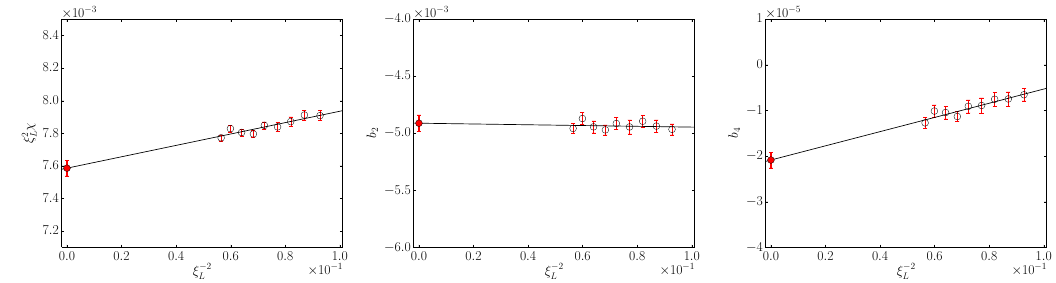
Figure 5 . Extrapolation to the continuum limit for N = 21 using the complete data sets and ignoring correlations among measures at different β L introduced by the simulated tempering. The extrapolations are plotted as filled points. Starting from above, we show results for ξ 2 χ , b 2 and b 4 , whose continuum values are respectively ξ 2 χ = 7 . 59(5) 2 . 1(2) 10 − 5 . Fits are stable varying the fit range and the reduced ˜ χ 2 (with 7 degrees of freedom) − · is 0.9, 0.5 and 0.4 respectively. Comparing these results with the ones reported in table 2 we observe that correlations affect the final estimate of the error just for b 2 and b 4 .